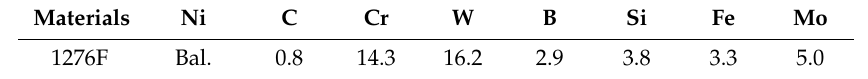
Table 1. Chemical compositions of Ni-based alloy powder used in the present study (mass %).